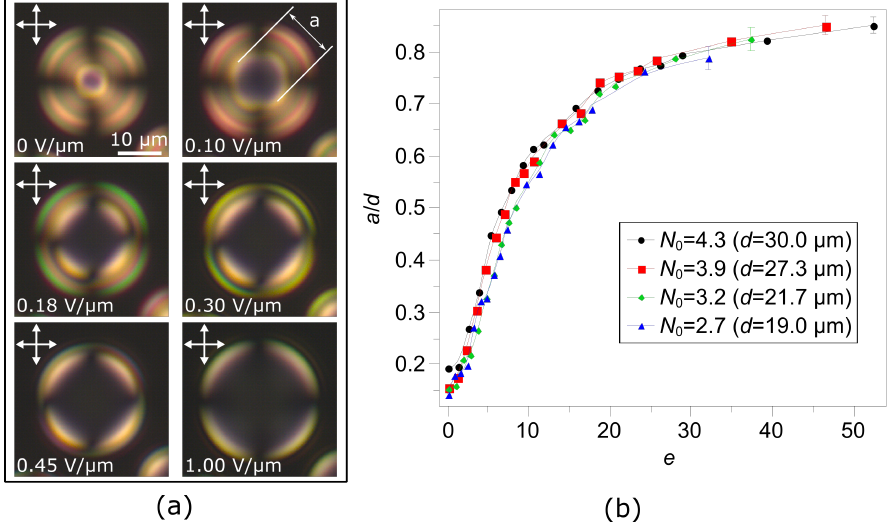
Figure 2. Polarizing optical microscope (POM) images of the cholesteric droplet at N 0 = 3.9 taken in the crossed polarisers for different applied electric fields values; the scale remains the same in all images ( a ). Dependencies of the a / d ratio on the applied dimensionless electric field e obtained for CLC droplets at different values of N 0 ( b ). Intrinsic helix pitch is p 0 = 14 µ